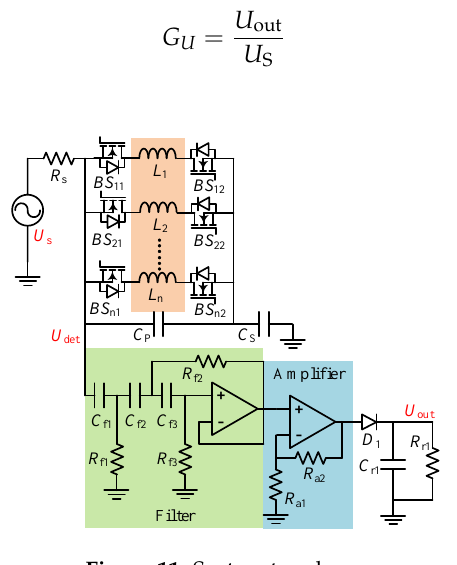
Figure 11. System topology.